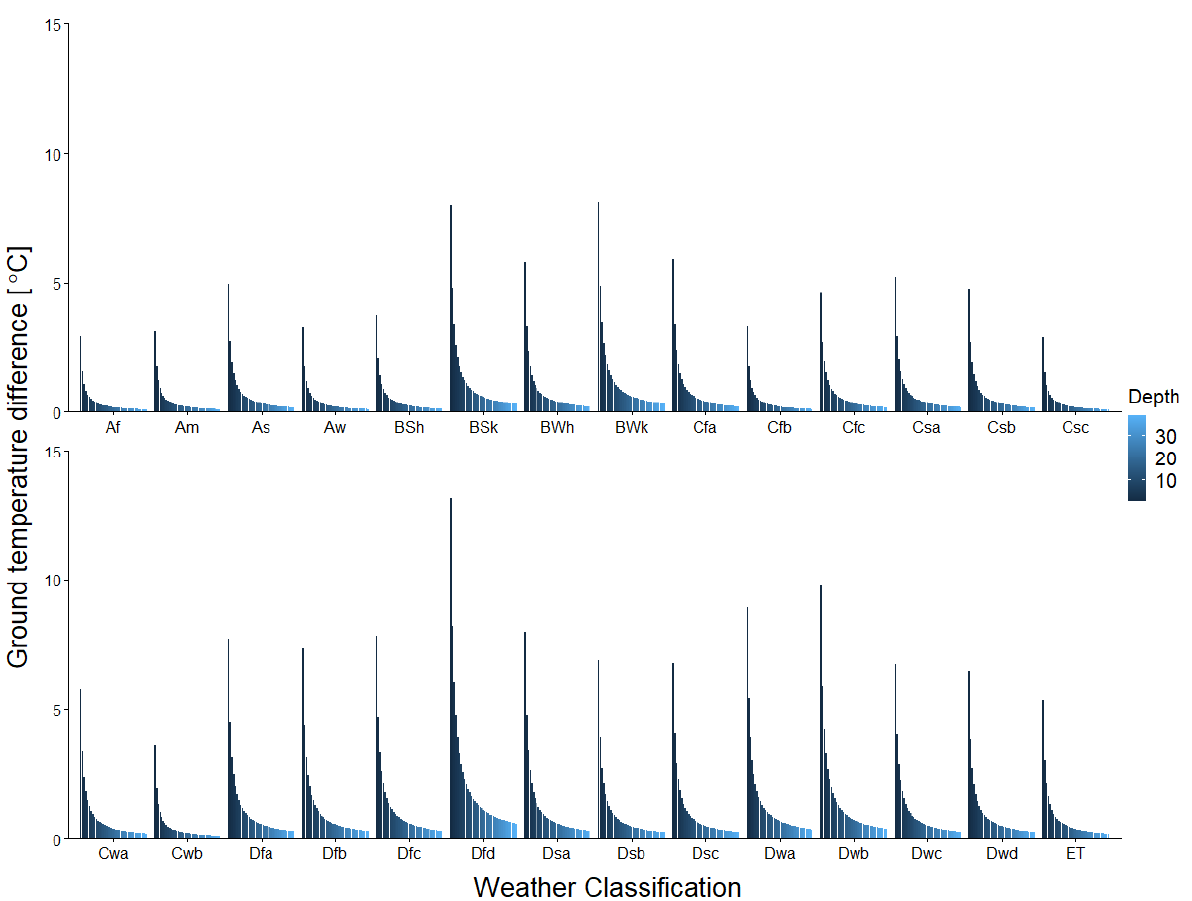
Figure 5. Ground temperature depending on weather and ground